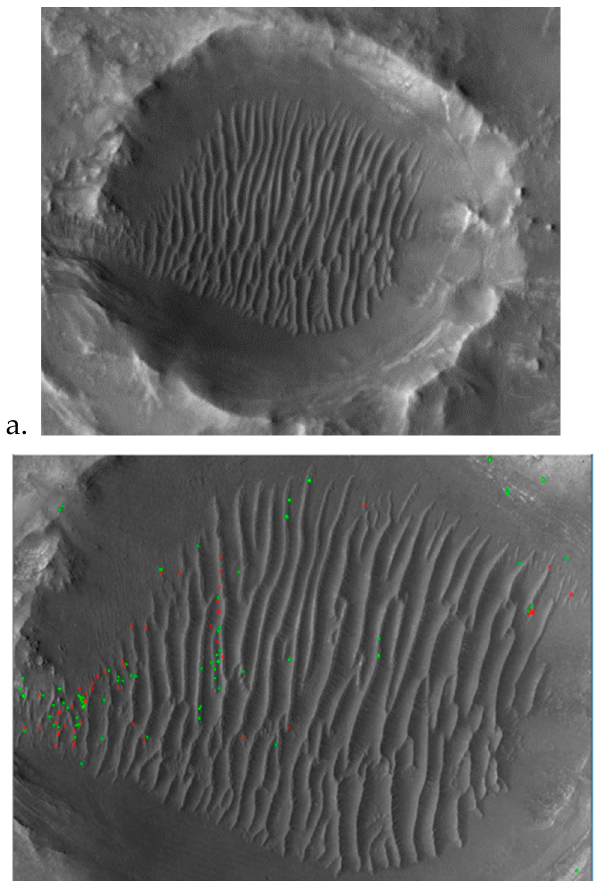
Figure 10. ( a ) Unnamed crater Jezero delta. High Resolution Imaging Science Experiment (HiRISE) Image ESP_037396_1985. Map projected scale 25 cm/pixel. North is up. Acquired 19 July 2014. (Image NASA/JPL/University of Arizona). ( b ) Defects extracted using the full resolution image (3088 × 2280 pixels). Green circles and red squares are bifurcations and terminations respectively. Defects missed by the MINDTCT algorithm not shown.